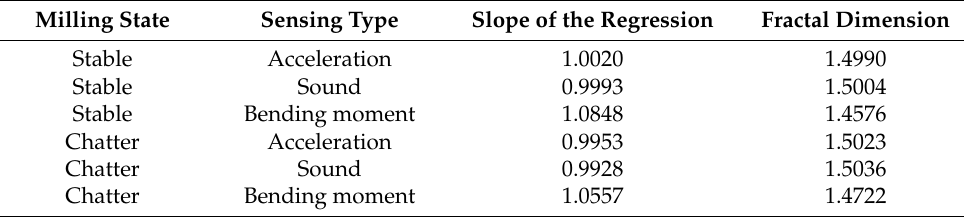
Table 2. Calculation results of fractal